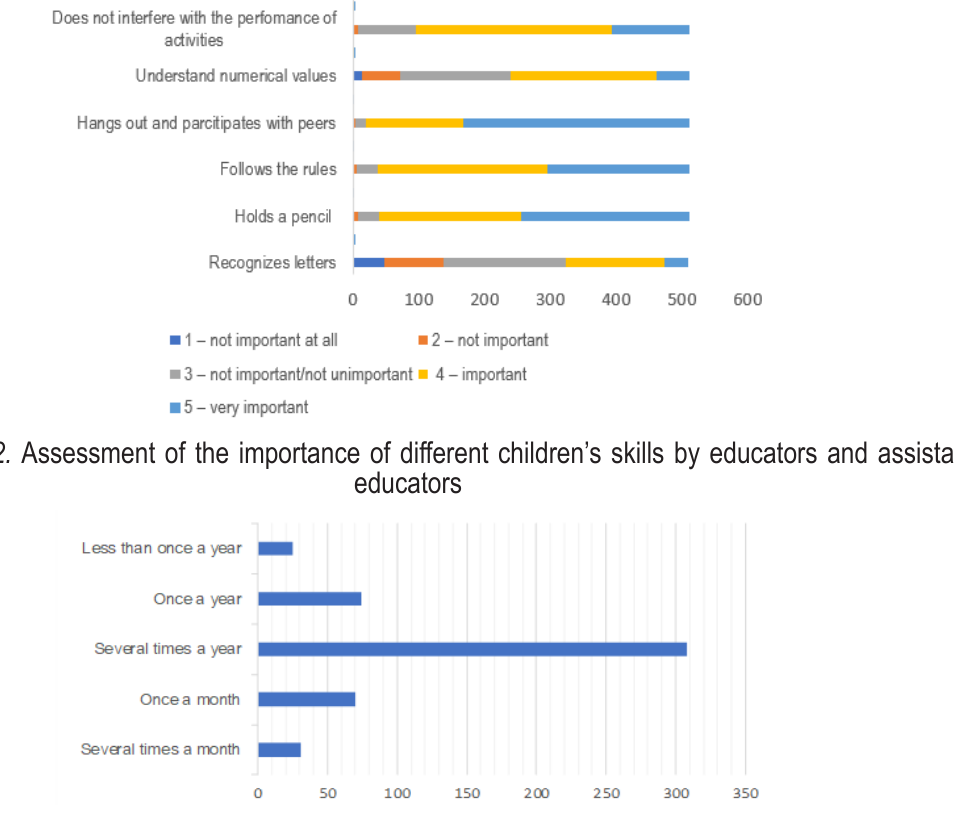
Figure 3. Participation in trainings related to professional development and knowledge of the concept of self-regulation